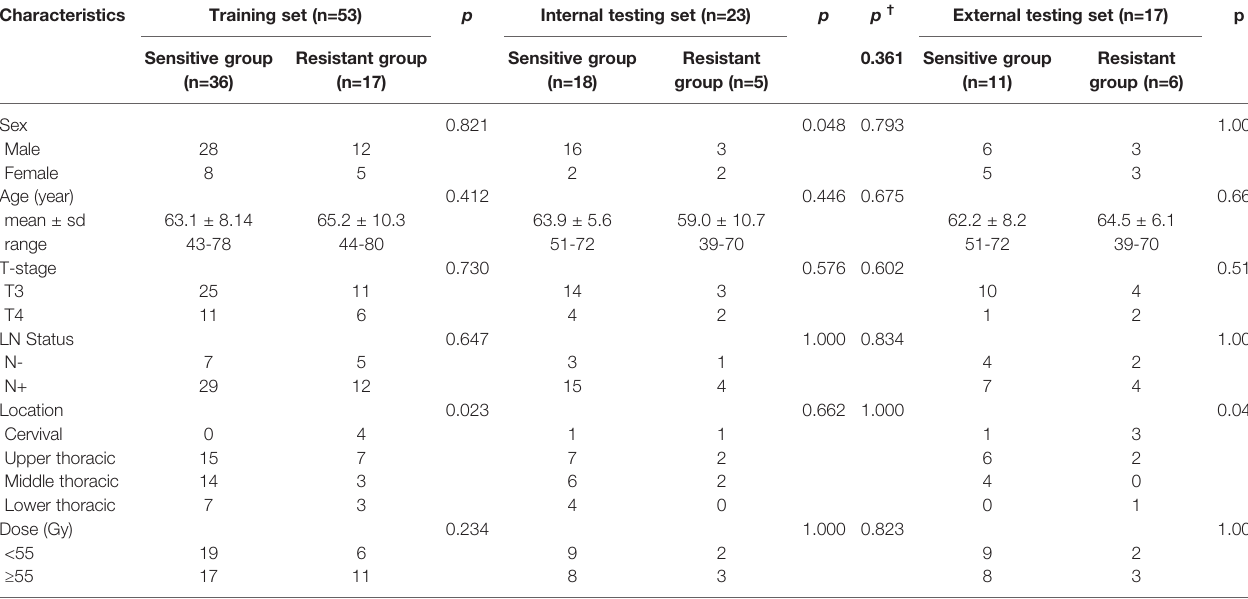
LN, lymph node. † Difference between the training set and the internal testing set in characteristics of patients and tumor. *P < 0.05, statistically signi fi cant.